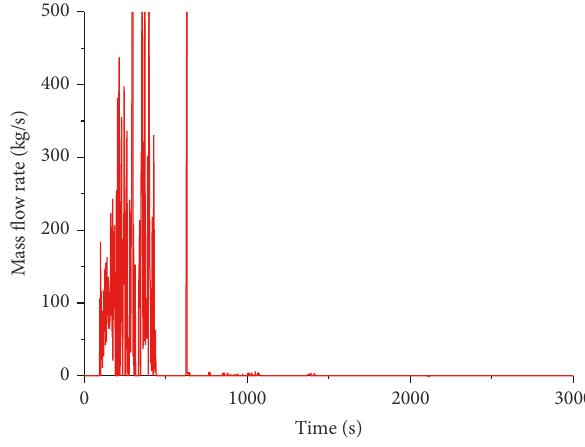
Figure 20: Accumulator-1 injection rate.